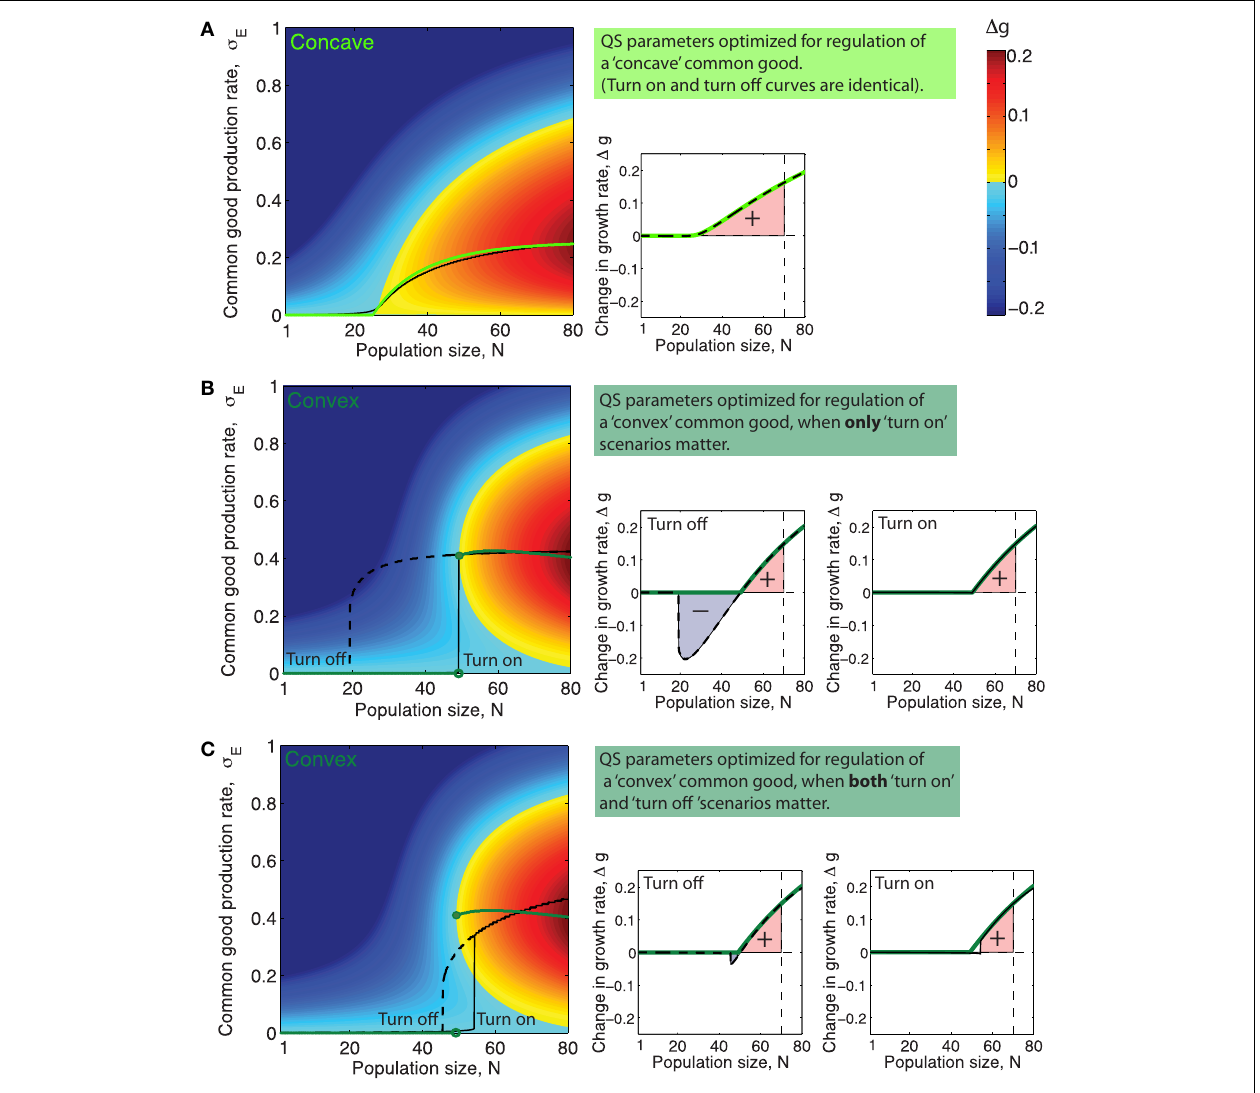
FIGURE 5 | Quorum sensing parameters optimized for different ecological scenarios and different types of public goods. (A–C) Left side panels: Green curves shows optimal production rate, σ opt E , as a function of population size N . Black full line and dashed line show the production rate as a function of population size, N , when production is regulated by (A) : a QS system with parameters such that cumulative fitness, w is optimized for a public good with the concave benefit function shown in Figure 1 ( α = 1 . 1 , K S = 2200 , σ max E = 0 . 33 ), (B) : a system with QS parameters for a public good with a convex benefit function maximizing cumulative fitness w in only “turn on” scenarios, ( α = 2 , K S = 980 , and σ max E = 0 . 43 ), and (C) : a QS system with